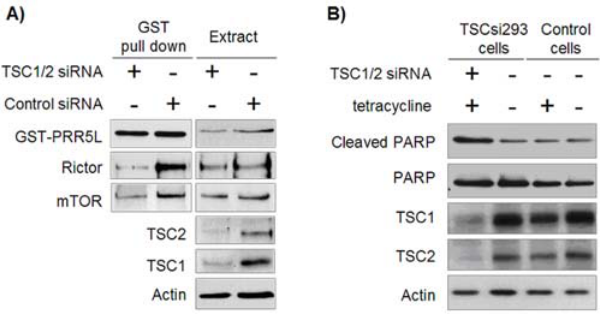
Figure 6. Analysis of TSC1/2 knock down cells. A. PRR5L is released from mTORC2 in TSC1/2 deficient cells. TSC knock down was induced in TSCsi293 cells by tetracycline treatment for 4 days. Cells were cotransfected with GST-PRR5L vector and incubated for 2 days, followed by GST pull downs and immunoblots with the indicated antibodies. GST-PRR5L was detected with an anti-GST antibody. B. TSC1/2 knock down facilitates apoptosis. TSCsi293 and T-REx-293 (control) cells were treated with tetracycline for 4 days. Apoptosis was induced by 1.5 h treatment with TNF a and cycloheximide. Extracts were probed with the indicated